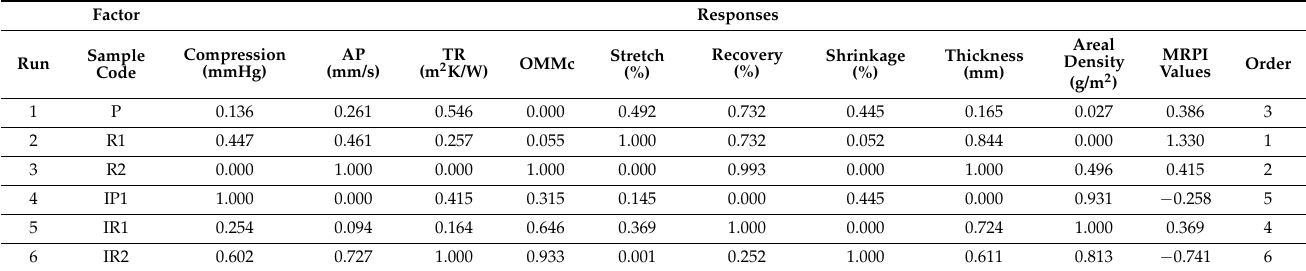
Table 12. Normalized S/N ratios and MRPI